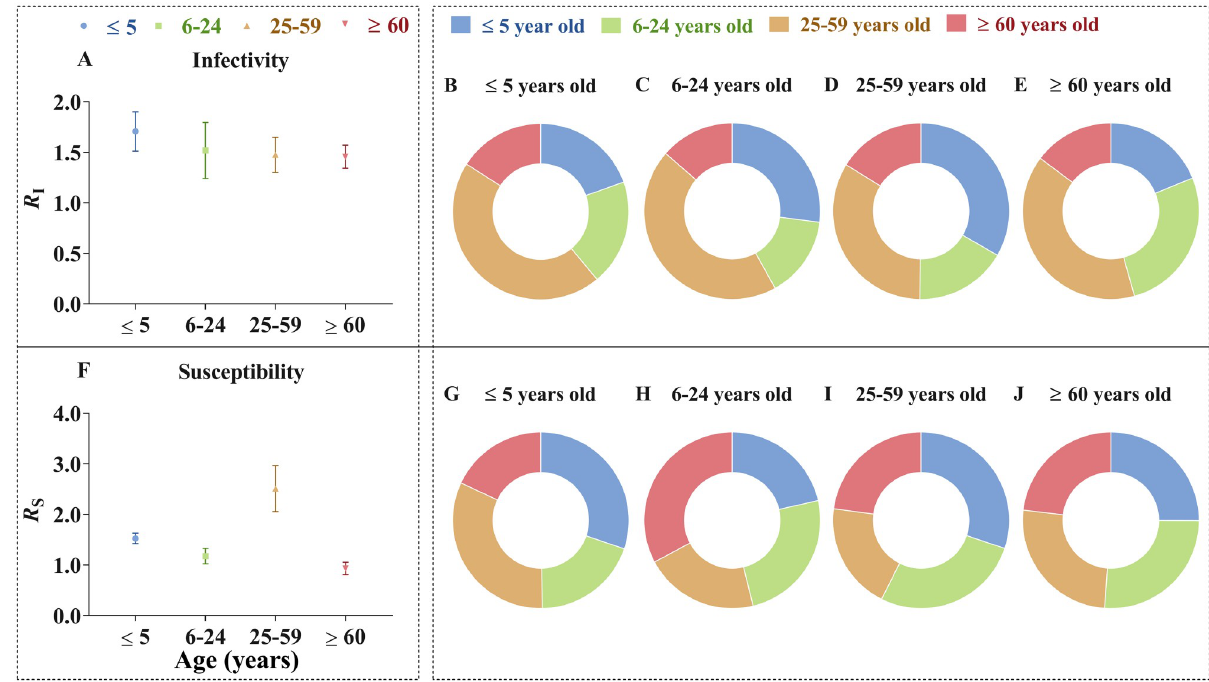
Fig 7. The infectivity, susceptibility and proportion of four age groups. The inside of the dashed line shows all subgraphs share one legend. R I in Fig 7A indicates infectivity of each age group, such as infectivity of � 5 years old ( R I-1 ) equals to sum of R eff-11 , R eff-12 , R eff-13 and R eff-14 . Fig 7B-7E respectively show the percentage of each age group in Fig 7A, such as there is a big percentage of infectivity from 25–59 years old to � 5 years old in Fig 7B. R S in Fig 7F is similar as description of Fig 7A, and Fig 7G-7J are similar as Fig